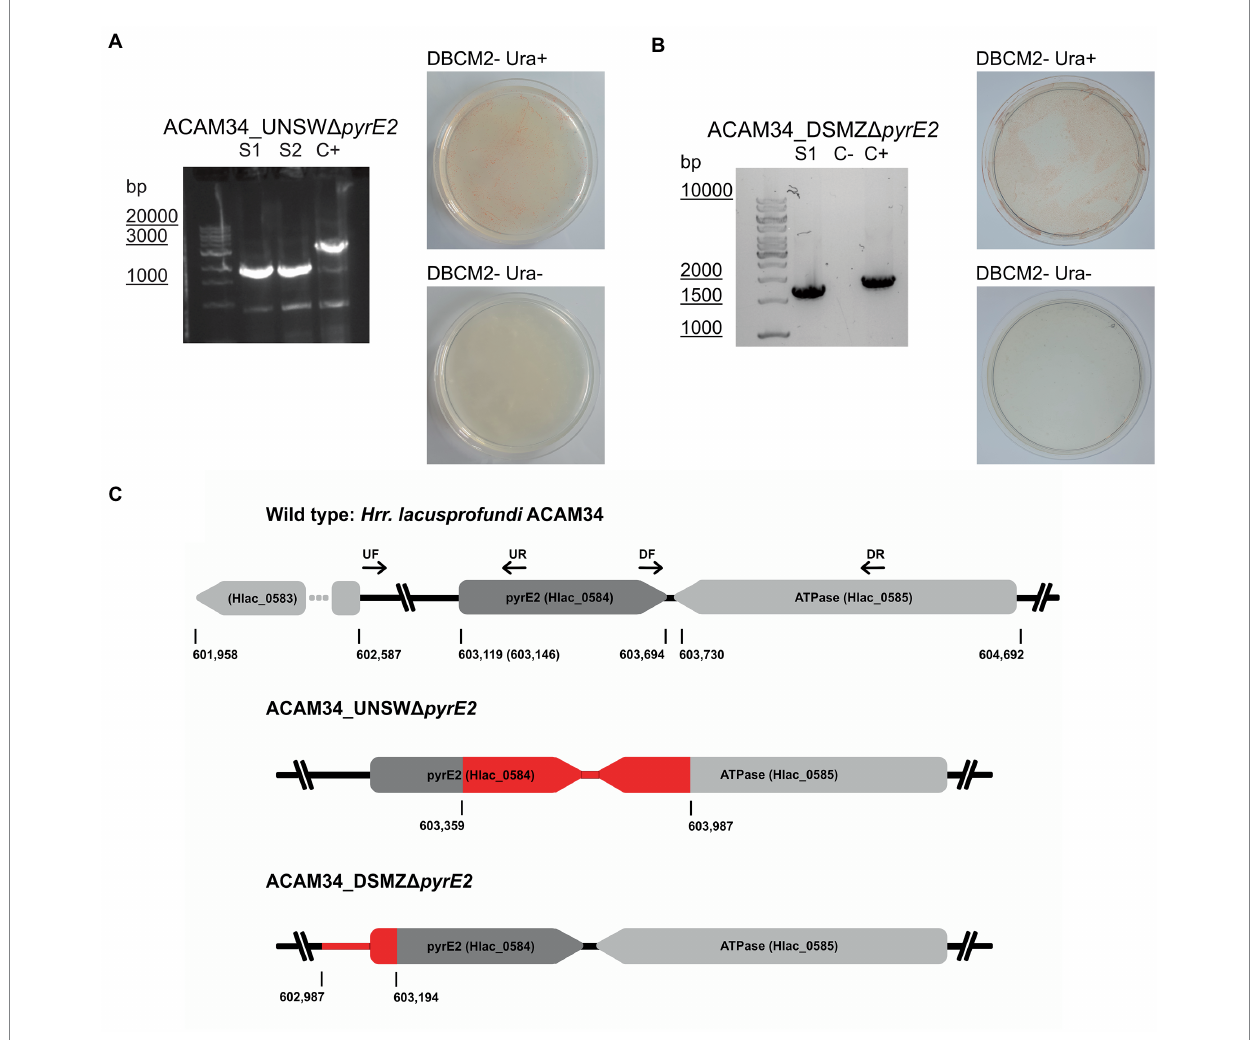
FIGURE 1 Successful pyrE2 knockout in Hrr. lacusprofundi ACAM34 strains. (A) Characterization of ACAM34_UNSW Δ pyrE2 mutants. Left: PCR on the pyrE2 locus of the two knockout strains S1 and S2 (see also Supplementary Figure 2) and a wild-type ACAM34_UNSW control (C+). Right: Growth of ACAM34_ UNSW Δ pyrE2 on DBCM2- supplemented with uracil (top), and growth defect on DBCM2 − without uracil (bottom). (B) Characterization of ACAM34_ DSMZ Δ pyrE2 . Left: PCR on the pyrE2 locus of the knockout mutant, ACAM34_DSMZ wild-type DNA served as the positive control (+C) (see also Supplementary Figure 5). Right: Growth of ACAM34_DSMZ Δ pyrE2 on DBCM2- supplemented with uracil (top), and growth defect on DBCM2- without uracil (bottom). (C) Schematic representation of the genomes including the wild-type strain ACAM34_UNSW with the position (bp) of pyrE2 and neighboring genes. ACAM34_DSMZ and ACAM34_UNSW deviate in the length of the annotated pyrE2 gene, the different position is marked in brackets for ACAM34_DSMZ. The primer binding sites for upstream (UF, UR) and downstream (DF, DR) flanking regions are represented as arrows. The deletion in the ACAM34_UNSW Δ pyrE2 S1 and S2 clones is identical and highlighted in red. The deletion in ACAM34_DSMZ Δ pyrE2 is also highlighted in